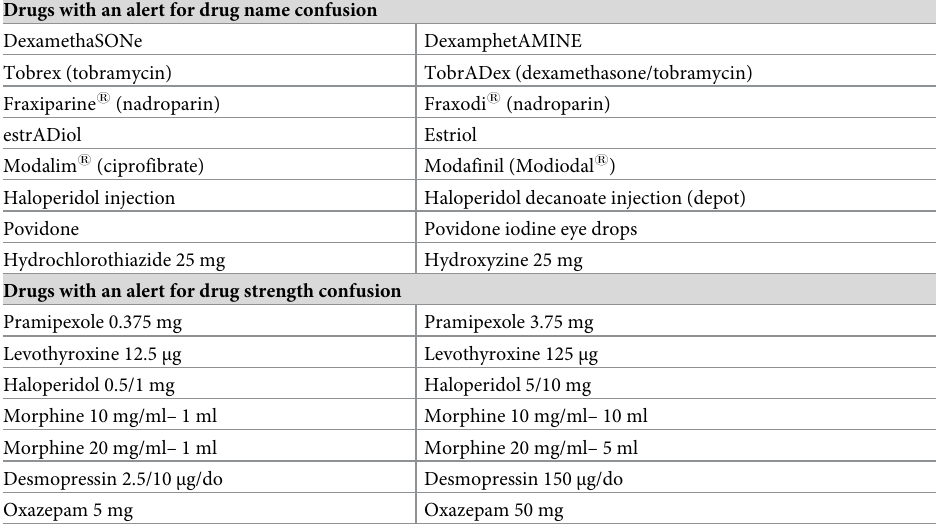
Table 1. Drugs with an alert for name and strength confusion [20].